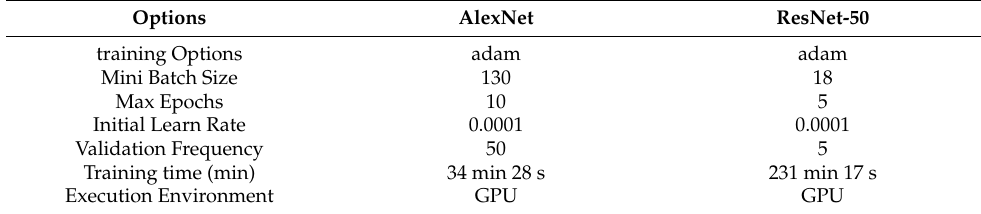
Figure 6. Confusion matrices. ( a ) Confusion matrix for the AlexNet to evaluate Alzheimer’s disease. ( b ) Confusion matrix for the ResNet-50 to evaluate Alzheimer’s disease. Table 9. Training Parameter Options ResNet-50 and AlexNet Models.